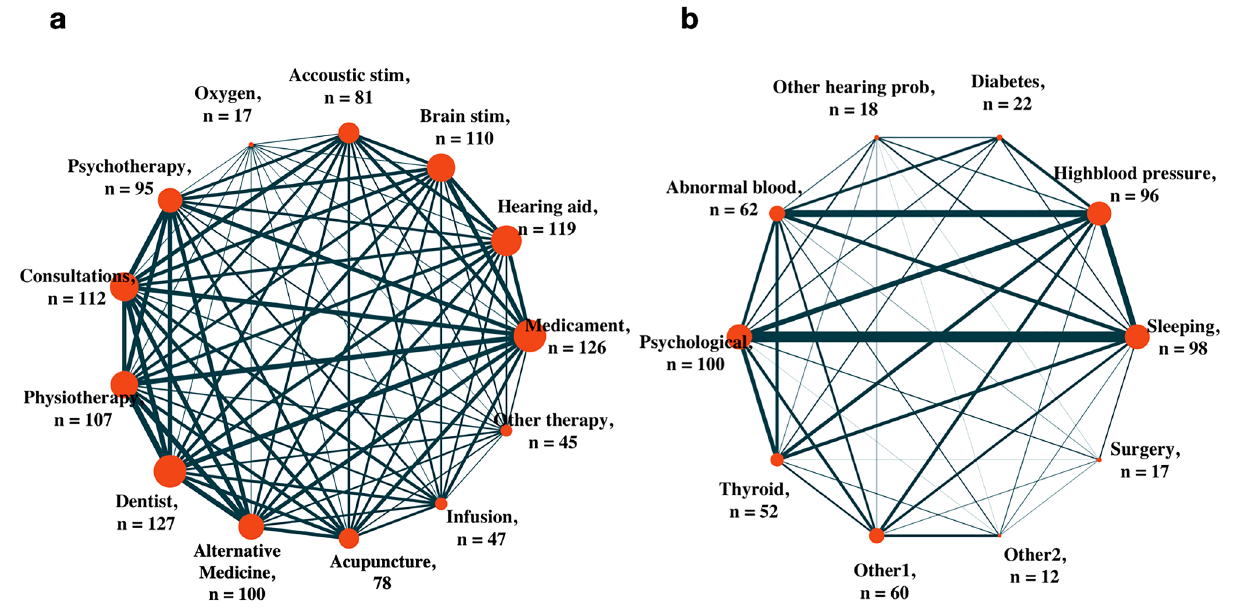
Figure 2. Network depiction of the relation between treatments ( a ) and comorbidities ( b ). The prevalence of comorbidities and the number of treatments undertaken by patients are represented by the size of the node. The link represents a pair of comorbidities experienced or treatments tried by a given patient, and its thickness represents the number of patients who experienced both comorbidities or sought both treatments.